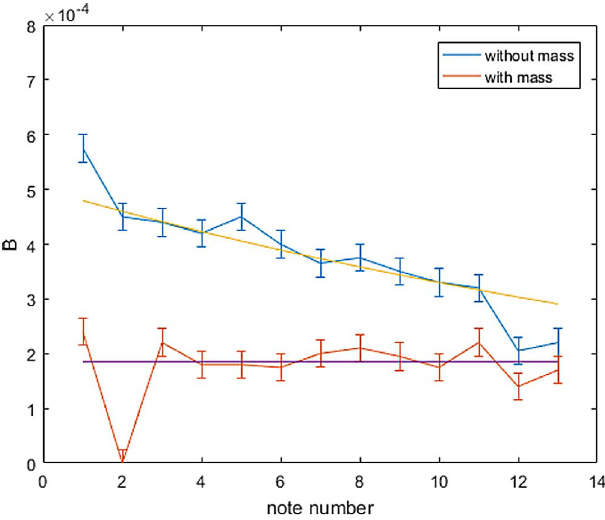
Figure 7. Inharmonicity coef fi cient B versus note number with (higher curve) and without (lower curve) added mass.